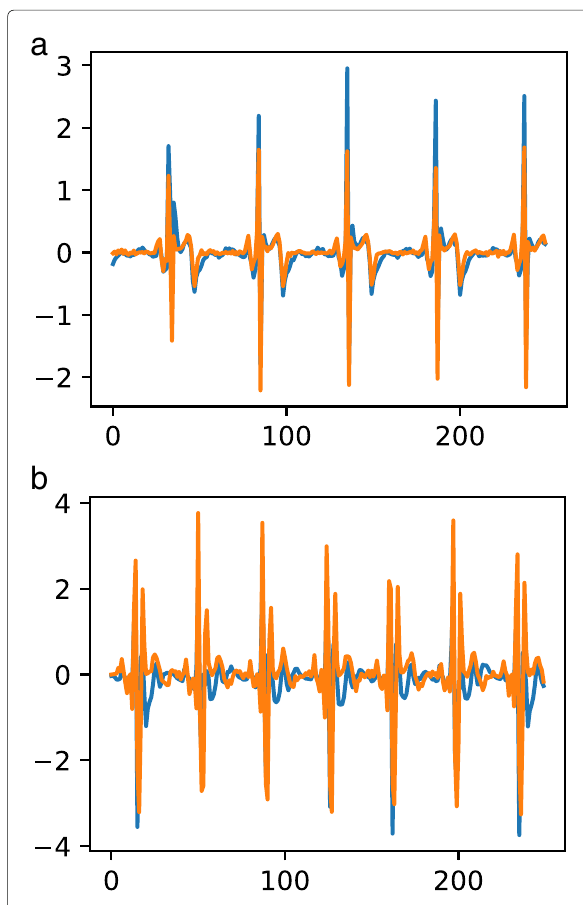
Fig. 15 Example prediction results of LSTM predictor. a Prediction for a healthy patient. b Prediction for a patient with myocardial